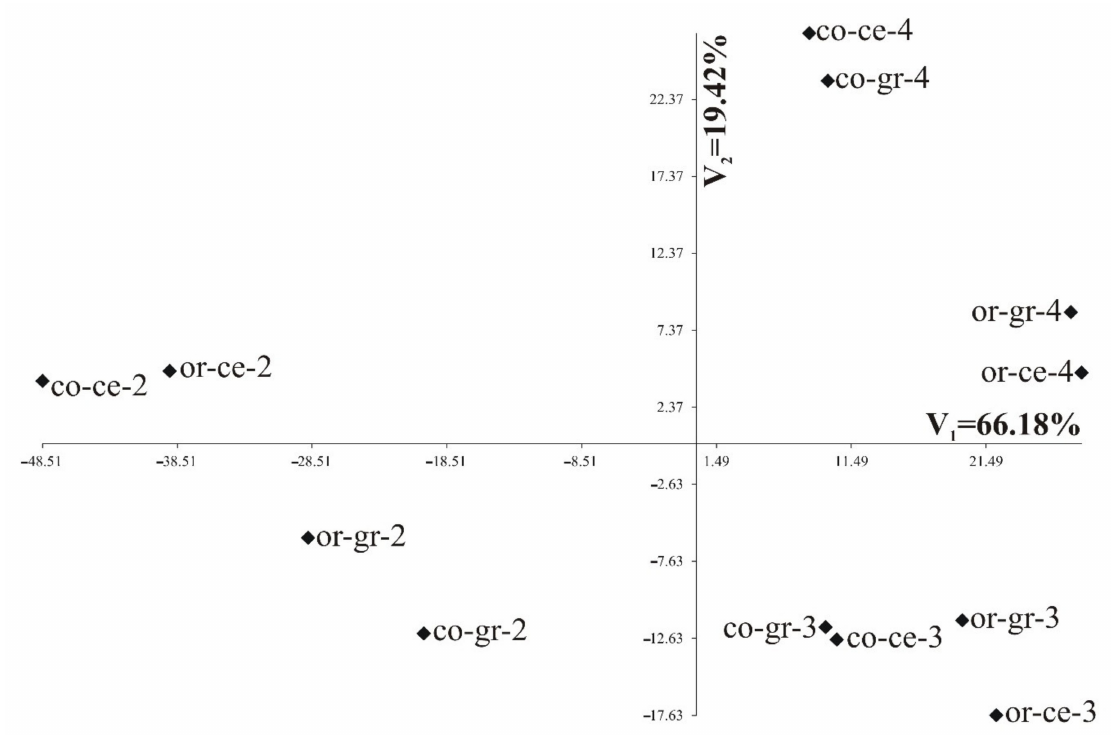
Figure 6. The distribution of all 12 combinations of farming systems, cultivars, and years of study in the two first canonical variates, based on all tested traits. In the diagram, the coordinates of a given combination of treatments are values of the first and second canonical variates. Co: conventional farming; or: organic farming; ce: Celer, gr: Grajcar; 2–4: years